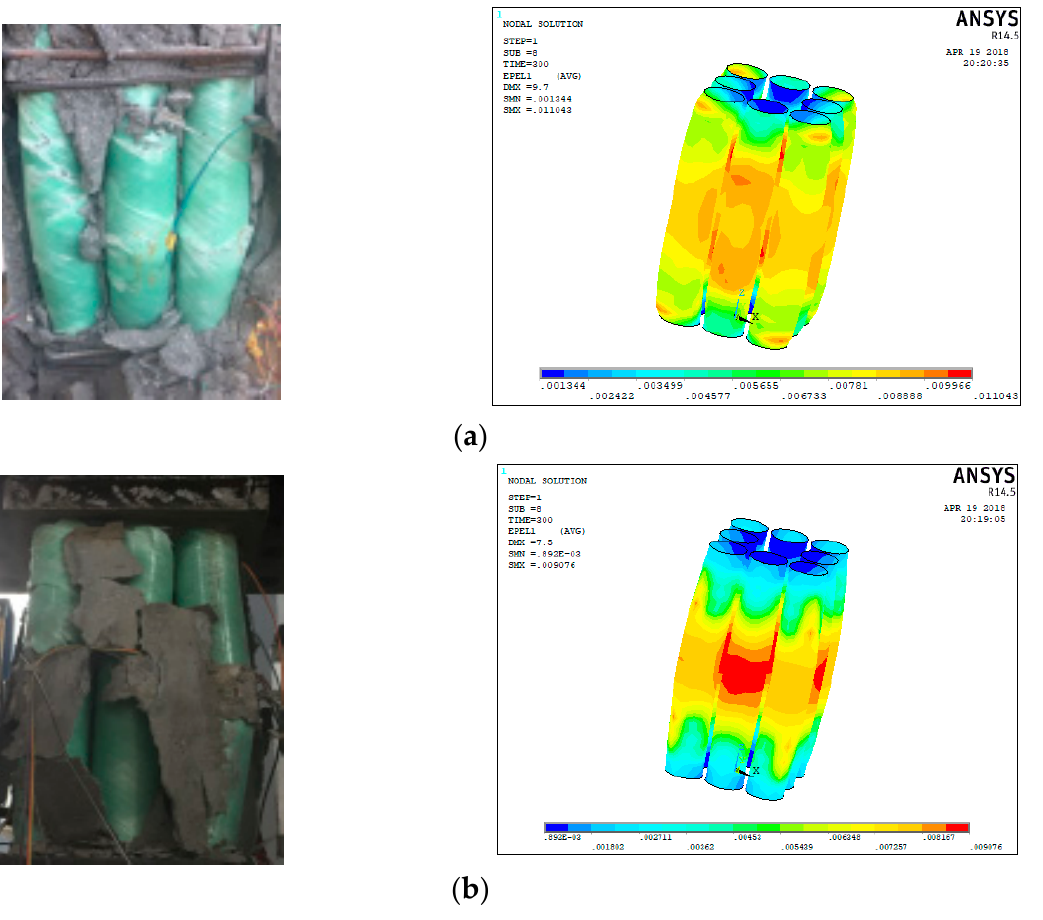
Figure 11. Comparisons of the failure mode of the tubes: ( a ) specimen T8 and ( b ) specimen T8N.